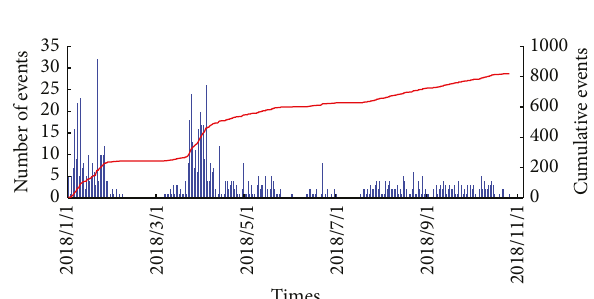
Figure 6: Time distribution of microseismic events in the traffic tunnel.